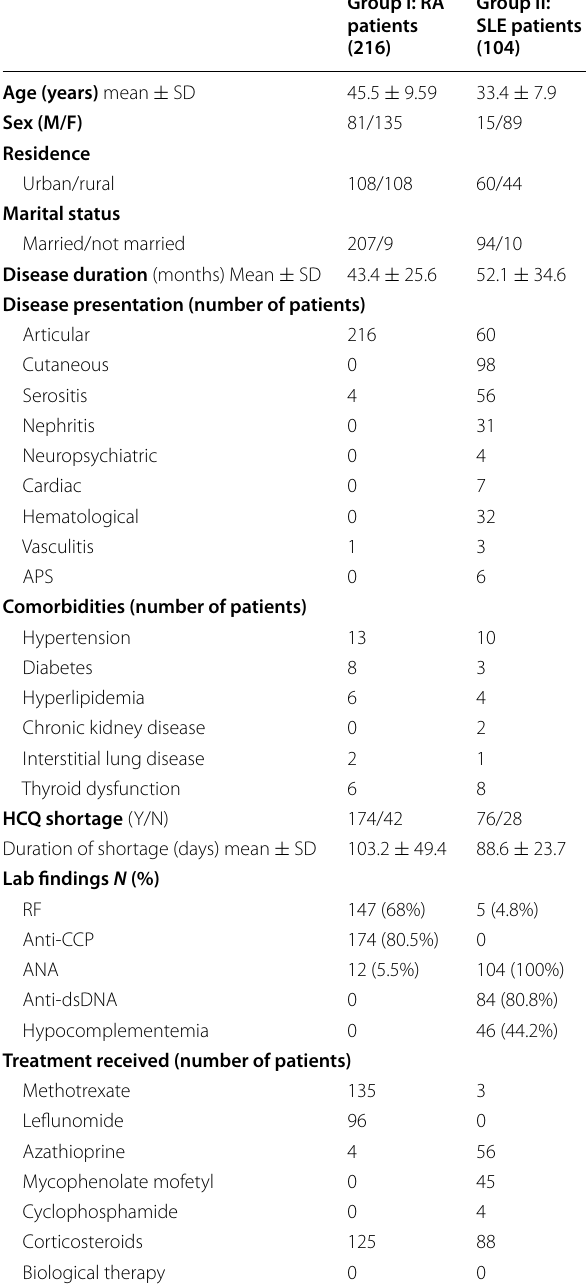
Table 1 Demographic and clinical data of both groups